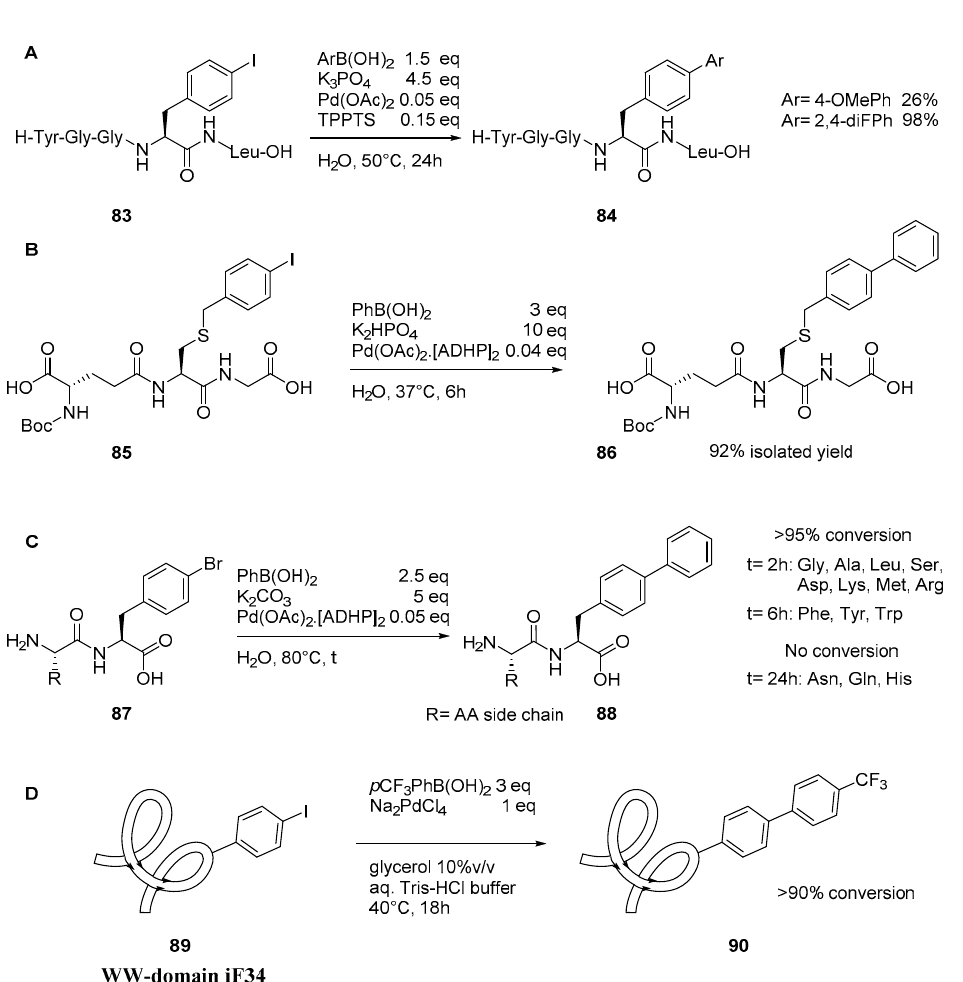
Figure 13. Suzuki–Miyaura reactions on peptides ( A ) Unprotected pentapeptide 83 as a substrate. ( B ) Internal p -iodobenzylcysteine residue transformed to biaryl tripeptide 86 . ( C ) Use of unprotected dipeptides 87 . ( D ) Derivatization of 34-mer 90 .